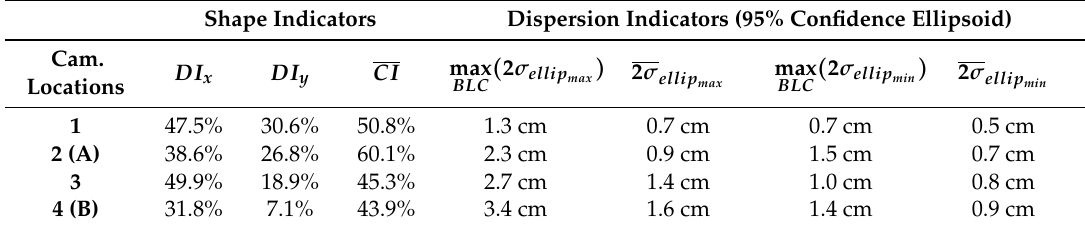
Table 4. Camera. Estimation-clouds shape and measurements precision.